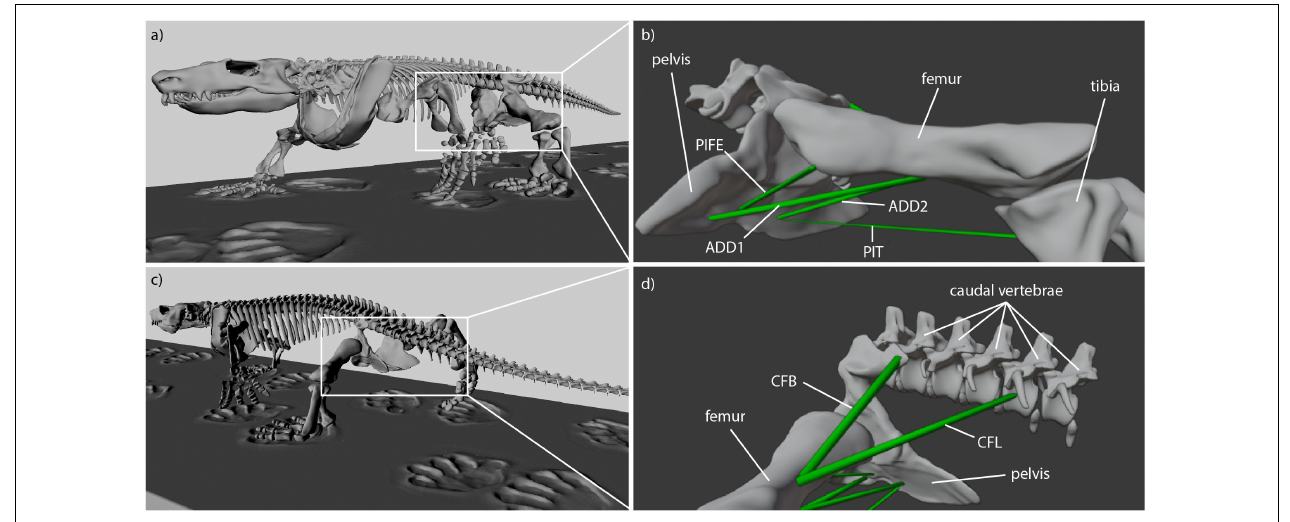
FIGURE 7 | Reconstructed muscle attachments and lines of action in Orobates. (a) Latero-frontal view of Orobates , (b) latero-frontal view of relevant skeletal elements to show adductor muscles (ADD1, ADD2, PIFE, PIT) at reference length (mid-stance), (c) latero-caudal view of Orobates , (d) latero-caudal view of relevant skeletal elements to show retractor muscles (CFB, CFL) at resting length